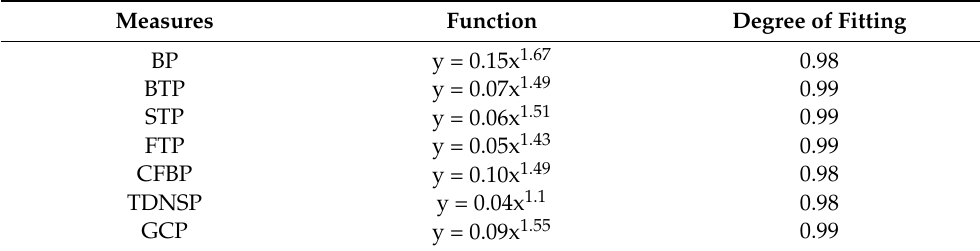
Table 3. Relationship between cumulative runoff and sediment yield under different ecological protection